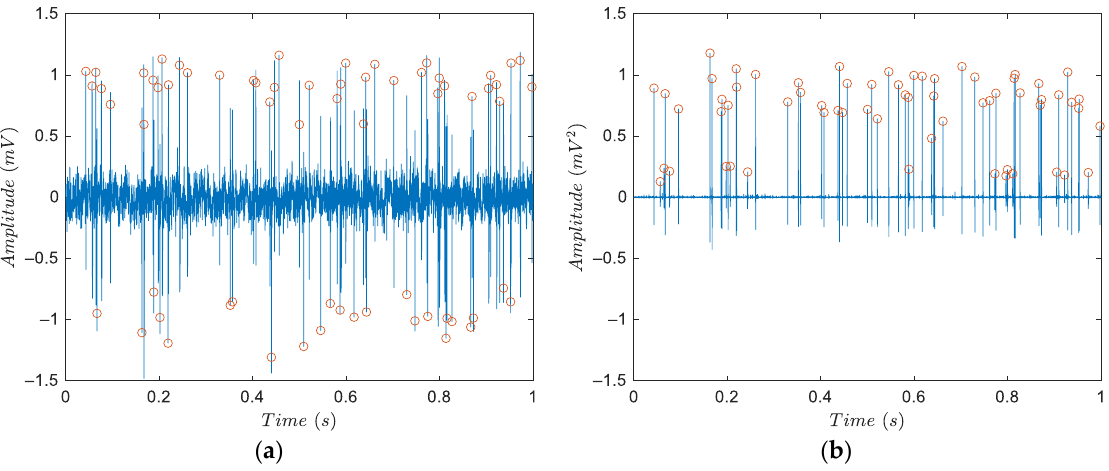
Figure 3. ( a ) The raw signal and ( b ) the enhanced signal after applying the proposed cascade of energy operators. It can be observed how the spikes are enhanced with respect to background noise, that is reduced. The red circle marks indicate the spikes position over the time.